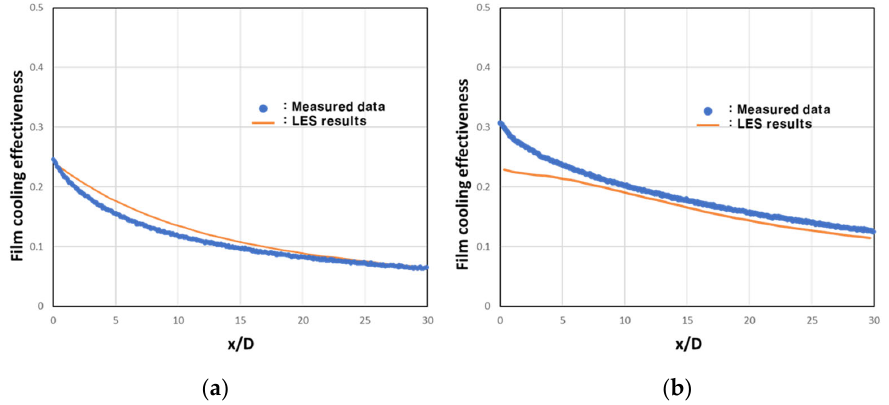
Figure 12. Laterally averaged film cooling effectiveness distributions at ( a ) BR = 1.0 and ( b ) BR = 2.0.